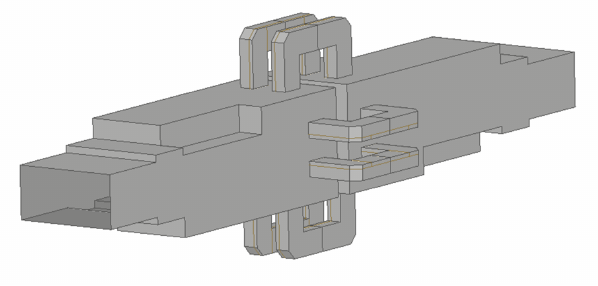
FIGURE 3. Back to back